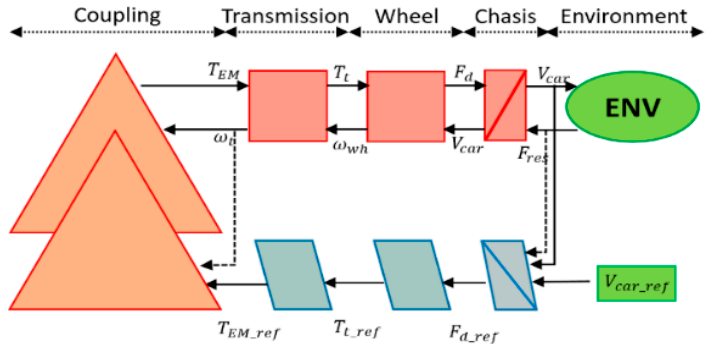
Figure 5. EMR structure for multi-applications.